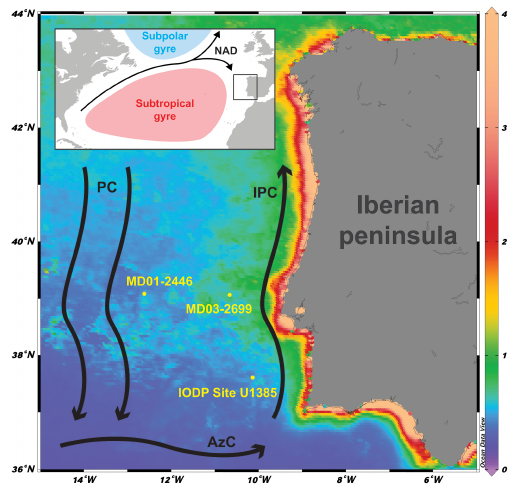
Figure 1. Core location and major currents in the area: NAD: North Atlantic Drift; PC: Portugal Current; IPC: Iberian Poleward Cur- rent; AzC: Azores Current. Background: chlorophyll a concentra- tion (mgm − 3 ; March, April, and May average, 2003–2018) derived from MODISA satellite data available at http://disc.sci.gsfc.nasa. gov/giovanni (last access: 11 July